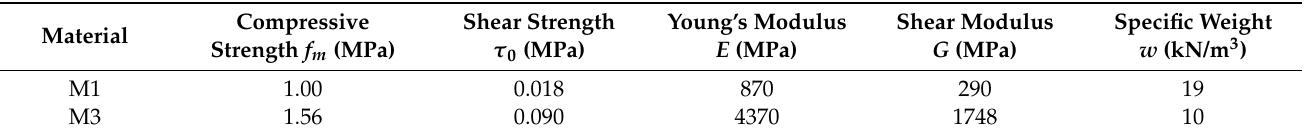
Table 1. Mechanical properties of masonry (values of elastic properties and strength to be reduced to 40% and 70%, respectively, and divided by CF).